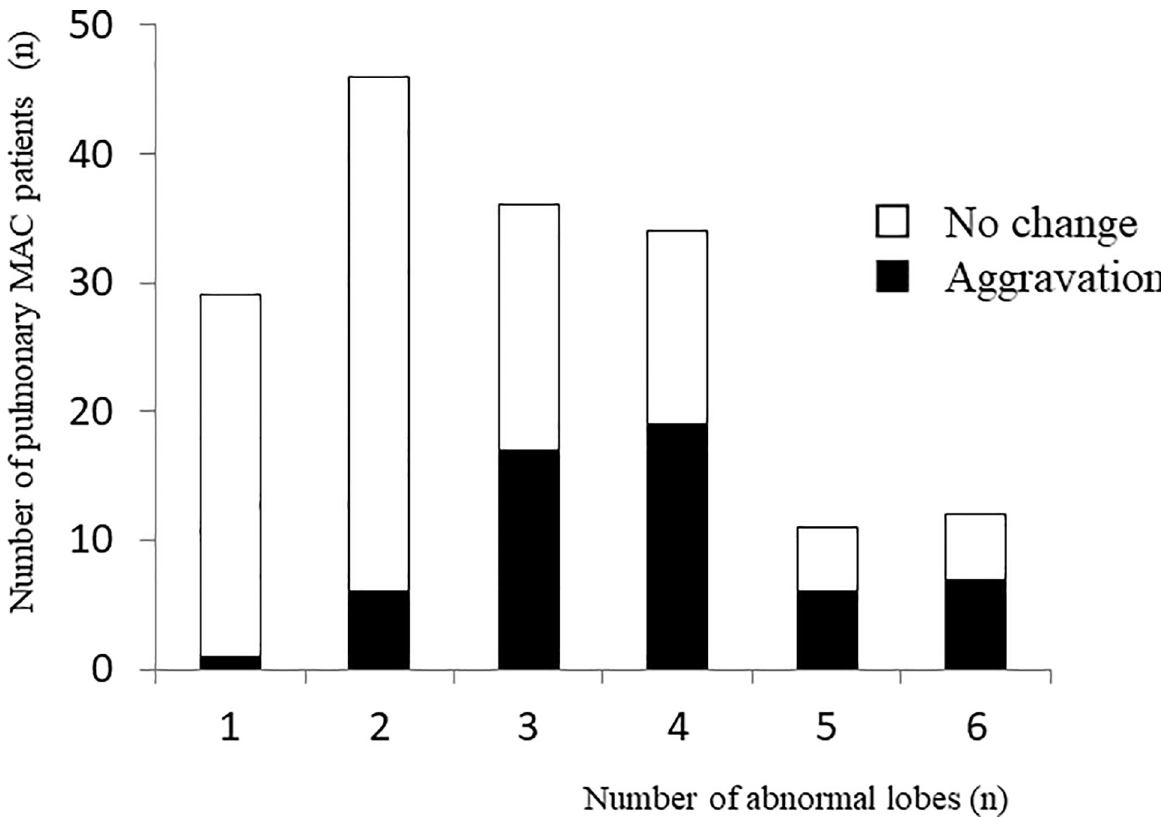
Fig 3. Aggravation by number of lung lobes with abnormalities. The black bar shows the number with radiological aggravation in each number of abnormal lobes, and the white bar shows that it has not changed. X-axis: Number of abnormal lobes, Y-axis: Number of pulmonary MAC